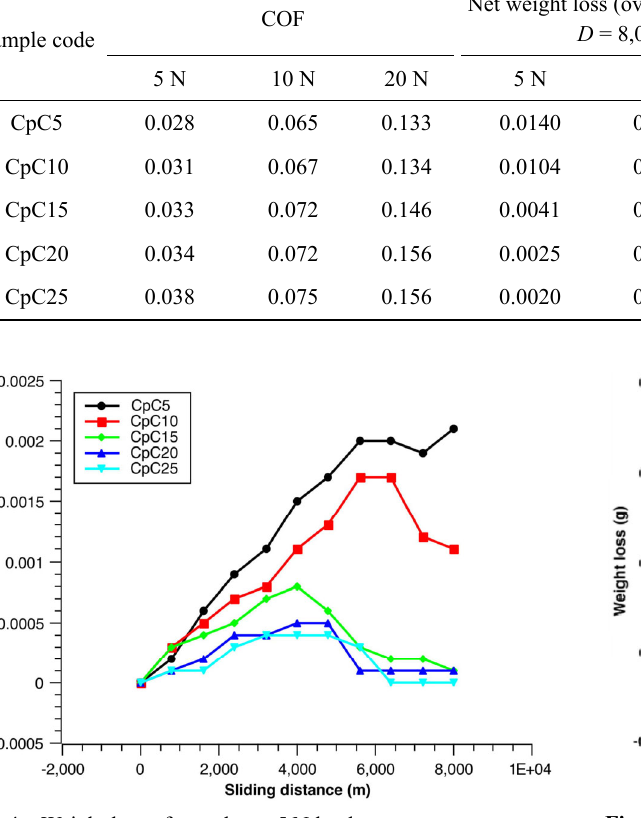
Fig. 4 Weight loss of samples at 5 N load. Fig. 5 Weight loss of samples at 10 N load.